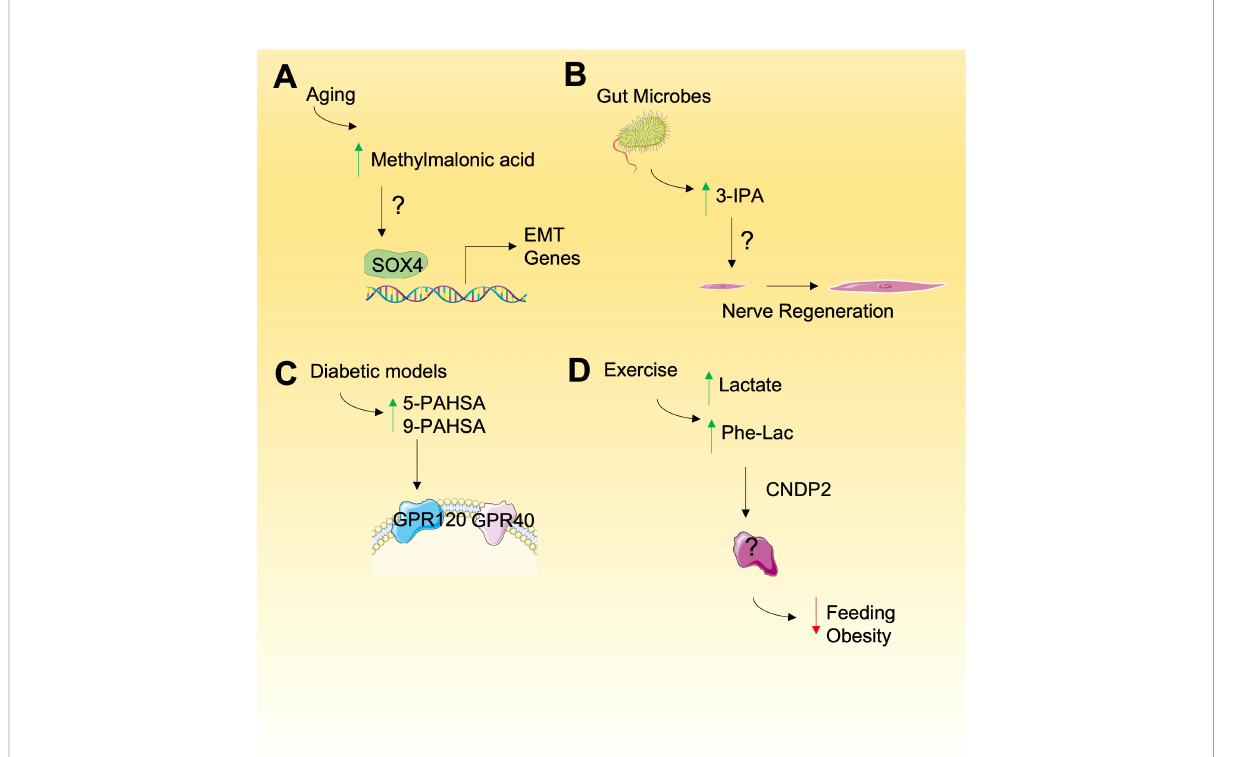
FIGURE 1 Emerging metabolites with unknown mode of action. (A) Methylmalonic is elevated during aging and may promote the expression of genes involved in epithelial-mesenchyme transition (EMT), relying on SOX4 but through unde fi ned mechanism. (B) Gut microbes produce 3-IPA that result in nerve regeneration and other phenotypes by unknown mechanisms. (C) Increased PAHSAs have been observed in diabetic models that my have a role in cancer by activation of cell signaling through GPRs. (D) N-lactoyl-phenylalalanine (Phe-Lac) is elevated during exercise and functions in an unknown manner to reduce feeding and obesity in